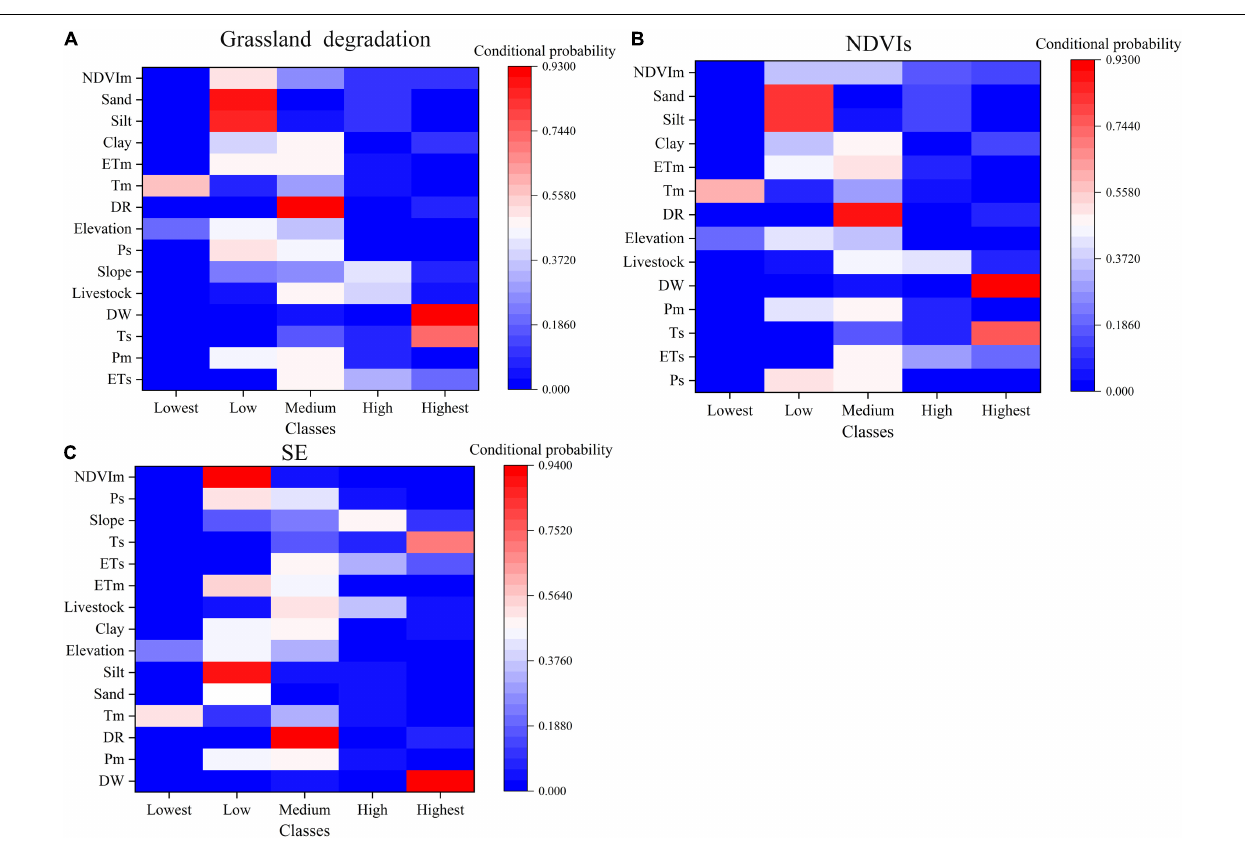
The result of grassland degradation risk in each grid was predicted by the selected evidence variables, as shown in Figure 12 . The risk probability values were about 21.65–87.15%. The region of high-risk grassland degradation ( P > 30%) covered 2.22 million ha, accounting for 15.94% of the total